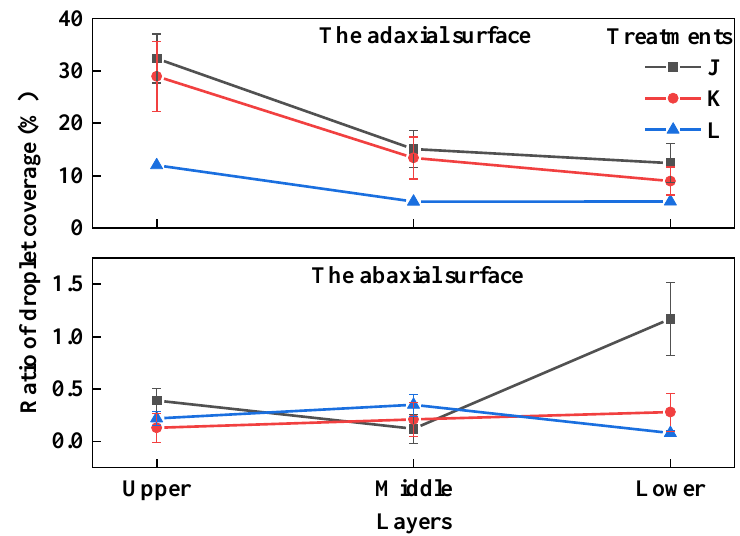
Figure 9. The ratio of droplet coverage distribution of using the traditional boom sprayer. Overall, the combination of the canopy-opening device and the divider device did not achieve better results. Compared with the traditional boom sprayer, the use of the canopy-opening device increased the average droplet coverage on the adaxial surface can- opy by more than 72.91% and the average droplet coverage on the abaxial surface canopy by more than 6.88%. This result showed that the use of the canopy-opening device signif- icantly improved the spraying coverage in the entire canopy of rice.